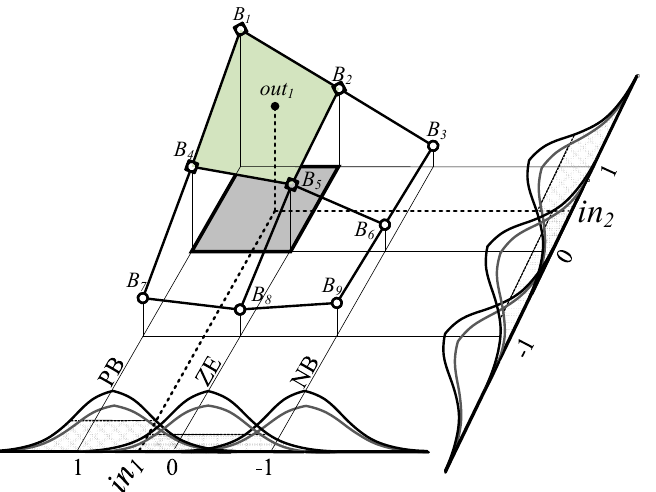
Figure 2. Control plane for two inputs controller with Gaussian type II membership functions with TPL.